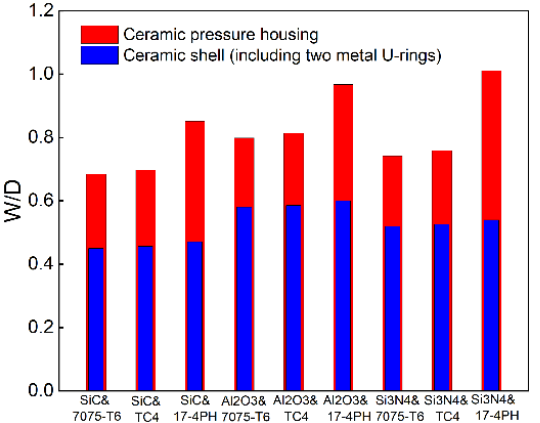
Figure 5. The W/D of the nine groups of ceramic pressure housings and ceramic shells.